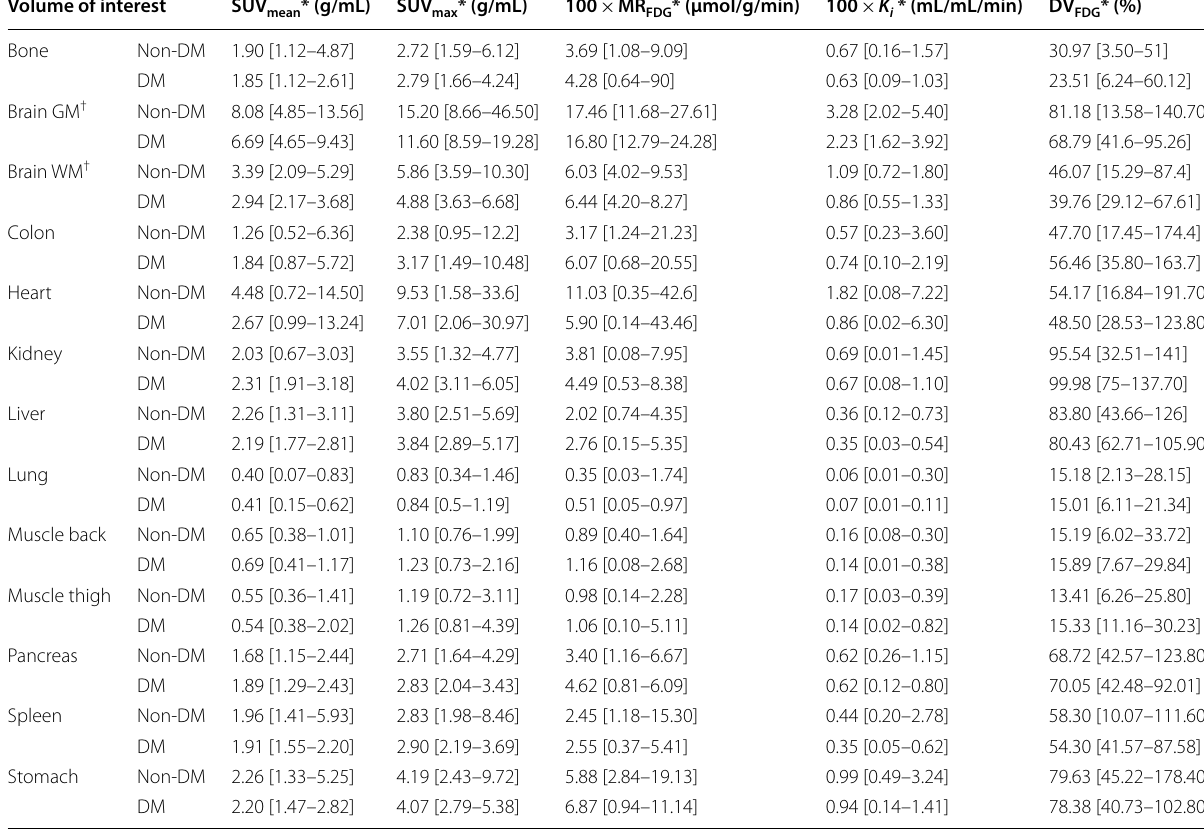
100) and the population with diabetes ( N =